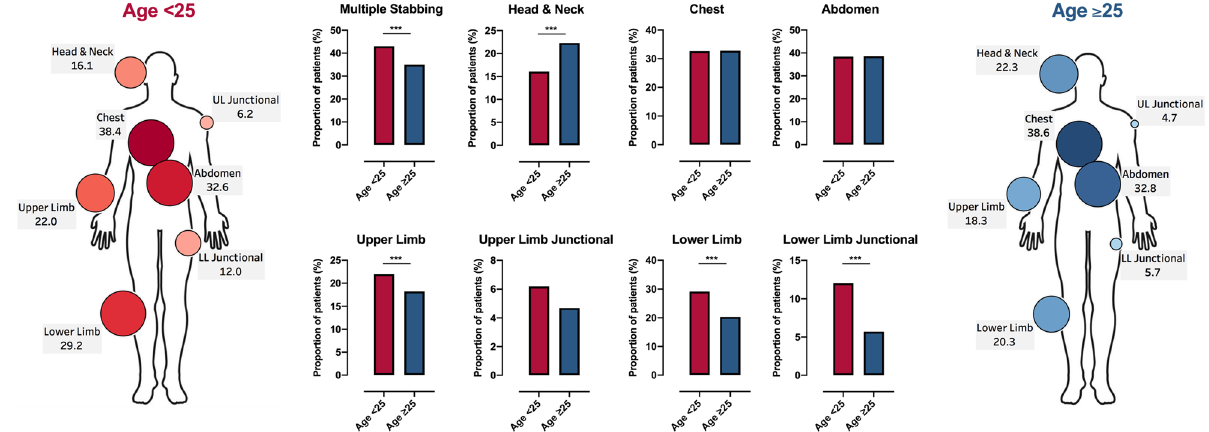
Figure 1. Age-related variation in anatomical profiles of stab injury. Circle size and colour in heatmaps depict proportion of patients with an injury in each area. Values are percentage of patients with an injury in the stated